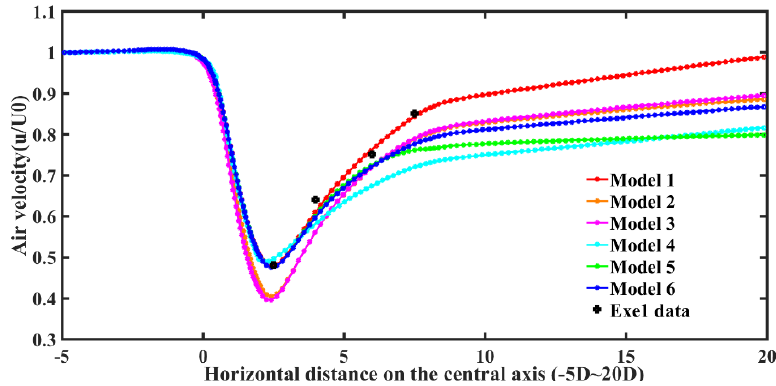
Figure 8. Velocity field at the center axis.